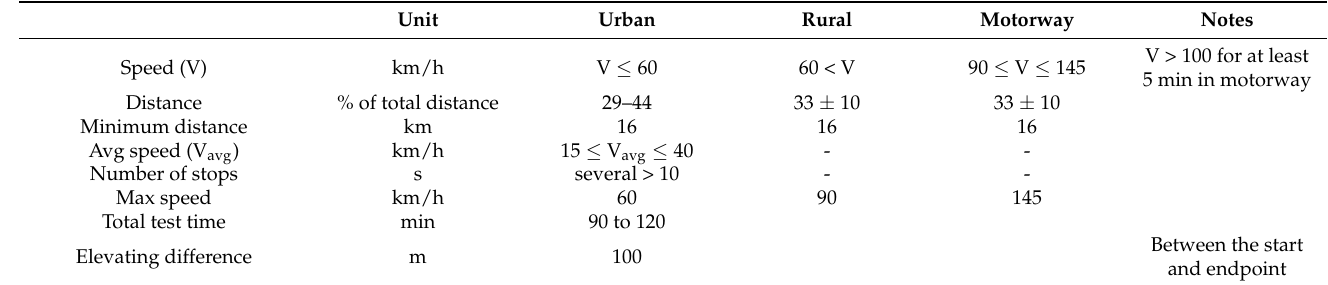
Table 5. EU RDE route design specification (Regulation